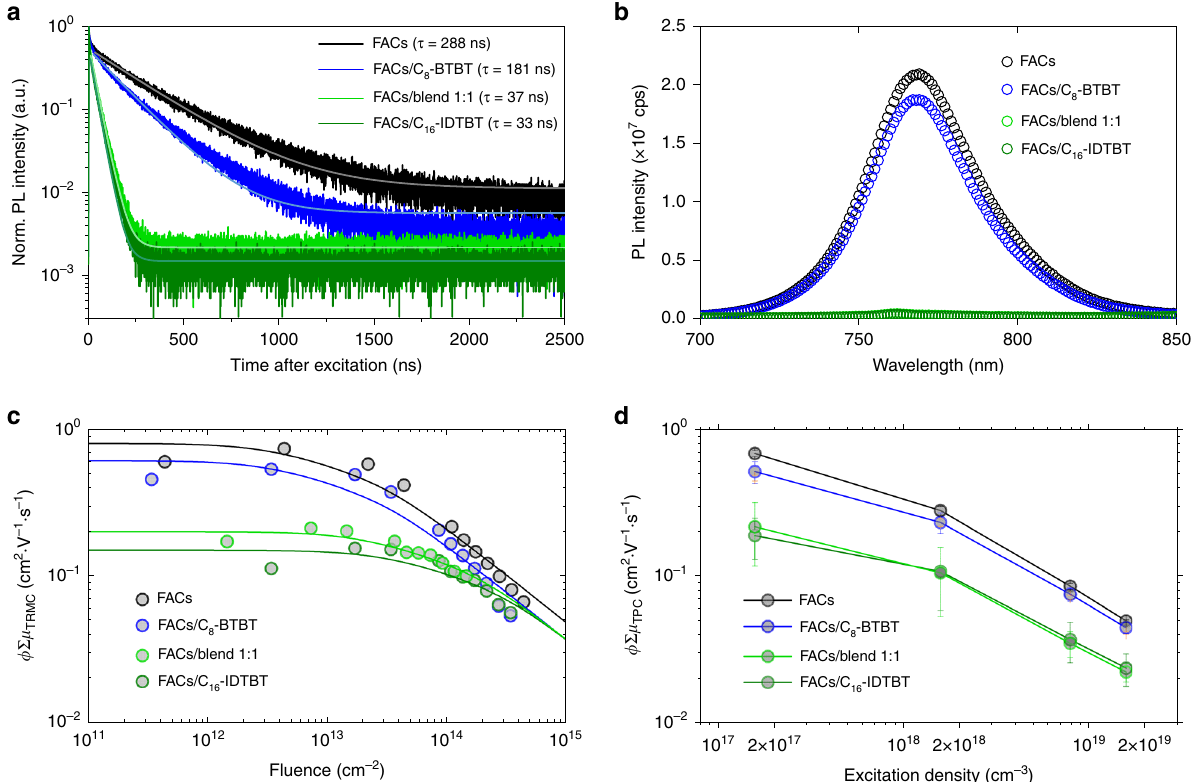
Fig. 3 Spectroscopic characterisations on photocarriers transfer dynamics. a , b Photoluminescence (PL) spectroscopy results for FACs and FACs/OSC bilayer stacks: a time-resolved PL (TRPL) measurements and b steady-state PL (SSPL) measurements. In ( a ) the time constant τ for each sample was extracted using the rate based on a mono-exponential decay. c Time resolved microwave conductivity (TRMC) fi gure of merit ϕ Σ μ TRMC = ϕ ( μ e + μ h ), plotted as a function of incident optical fl uence for FACs and FACs/OSC bilayer stacks on quartz substrates. The points are experimental data, and the lines are fi ts to a numerical model 37 , which accounts for bimolecular and Auger recombination at high fl uence. d Transient photoconductivity long-range lateral mobility ϕ Σ μ fl uences for FACs and FACs/OSCs bilayer stacks. The error bars denote TPC , plotted as a function of excitation density by varying incident laser standard